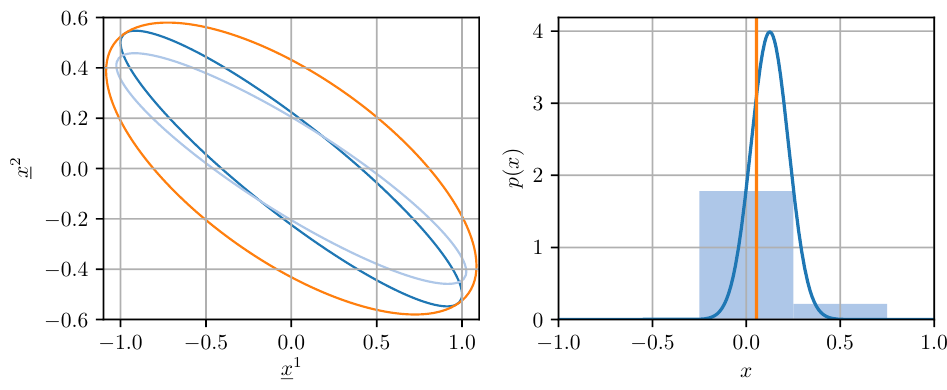
Figure 1. ( Left ): Confidence ellipsoids of a covariance matrix (dark blue), its naively quantized version (light blue), and its conservatively quantized version (orange). ( Right ): Density of a Gaussian random variable (dark blue), histogram (light blue), and mean (orange) of its quantized